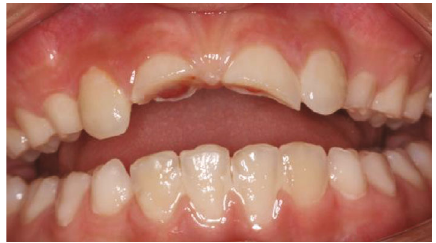
Figure 1: Fracture with pulp exposure in both incisors.